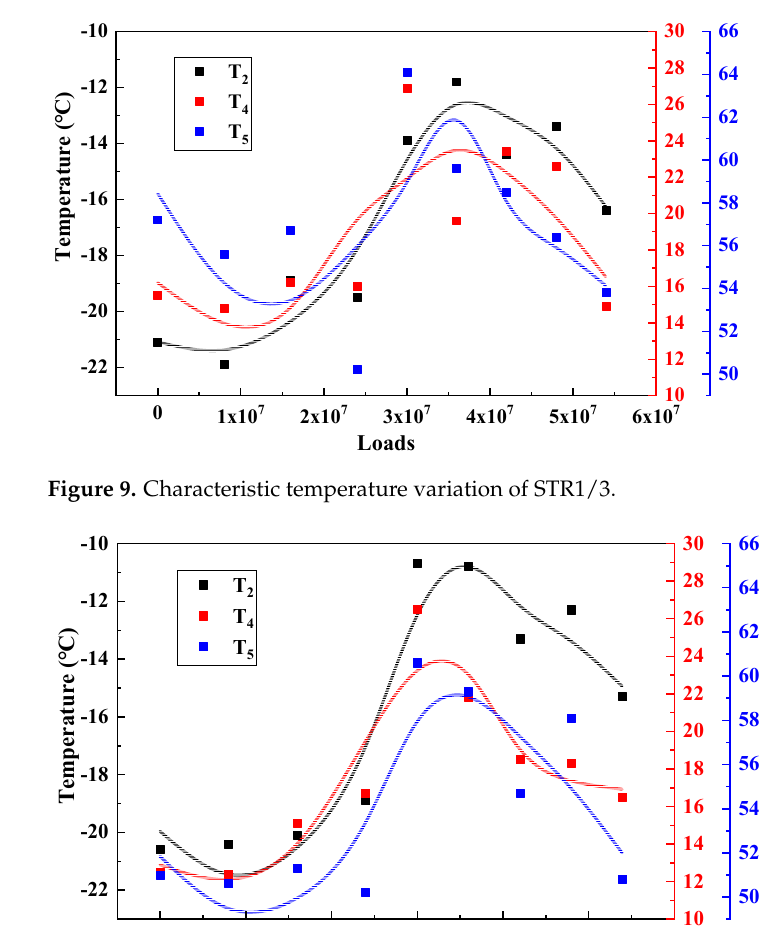
Figure 10. Characteristic temperature variation of STR10/12.